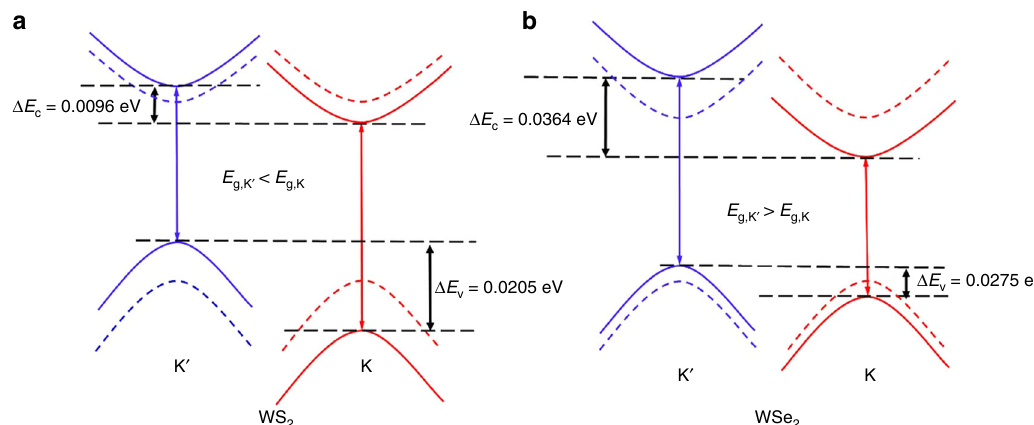
Fig. 7 Valley Zeeman splitting due to MEF. A schematic of the splitting of the conduction and valence bands responsible for A exciton transition at K and K ′ valleys for WS 2 ( a ) and WSe 2 ( b ). Spin up (down) bands are shown in red (blue). Dashed curves are for degenerate bands without a magnetic substrate; solid curves represent bands of TMDs with EuS substrate. In WS 2 , Δ E c < Δ E v , leading to a smaller E g in K ′ valley than that in K valley and a negative valley exciton splitting Δ E ex ; in WSe 2 , Δ E c > Δ E v , and E g in K ′ valley is lar g er than that in K valley, hence a positive Δ E